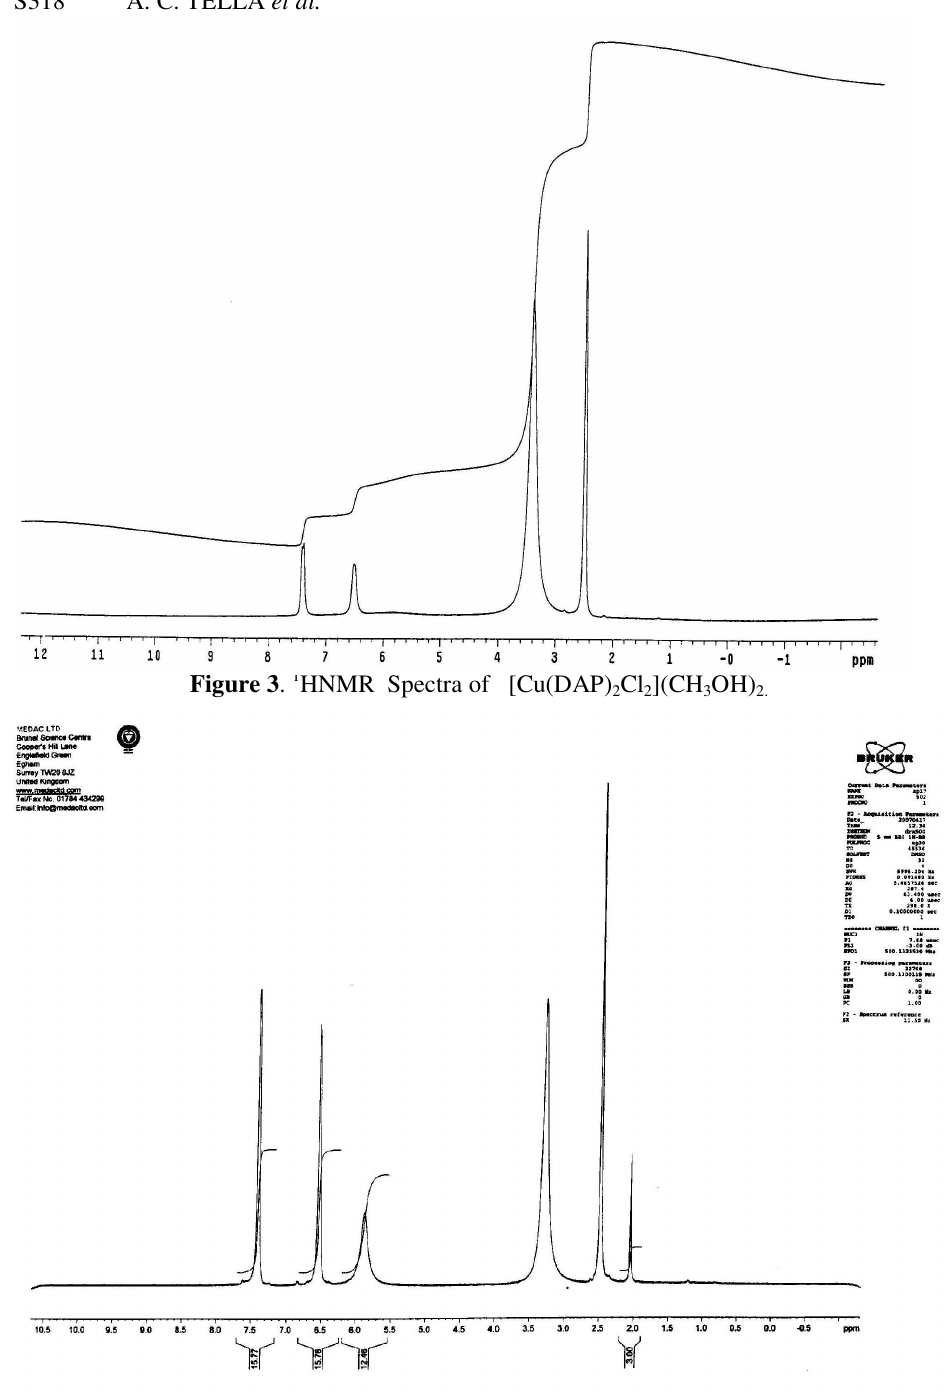
Figure 4 . 1 HNMR Spectrum of [Cu(DAP)(H